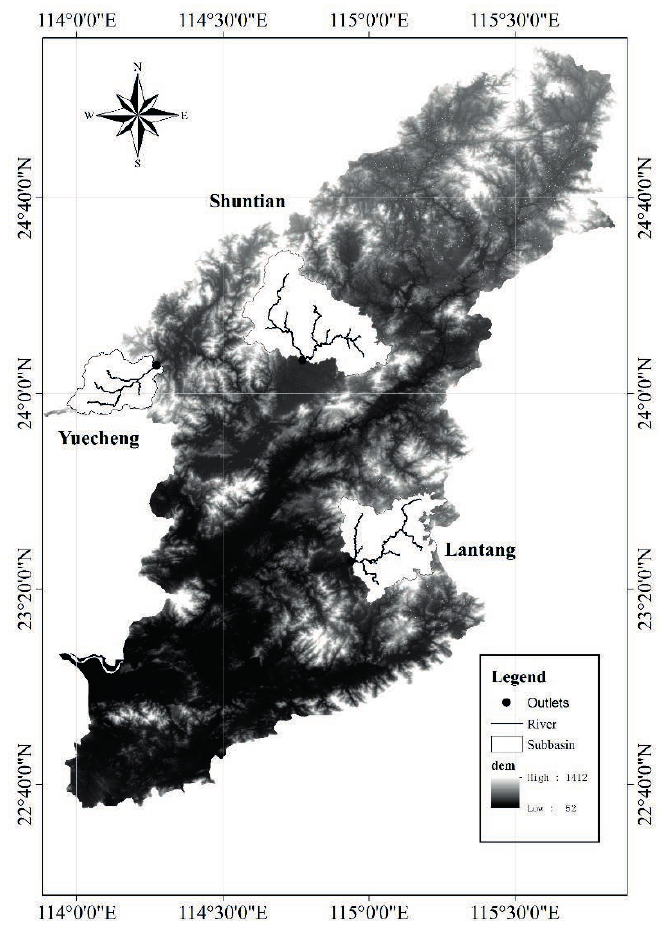
Fig. 1 The distribution of three objective basins in Dongjiang River